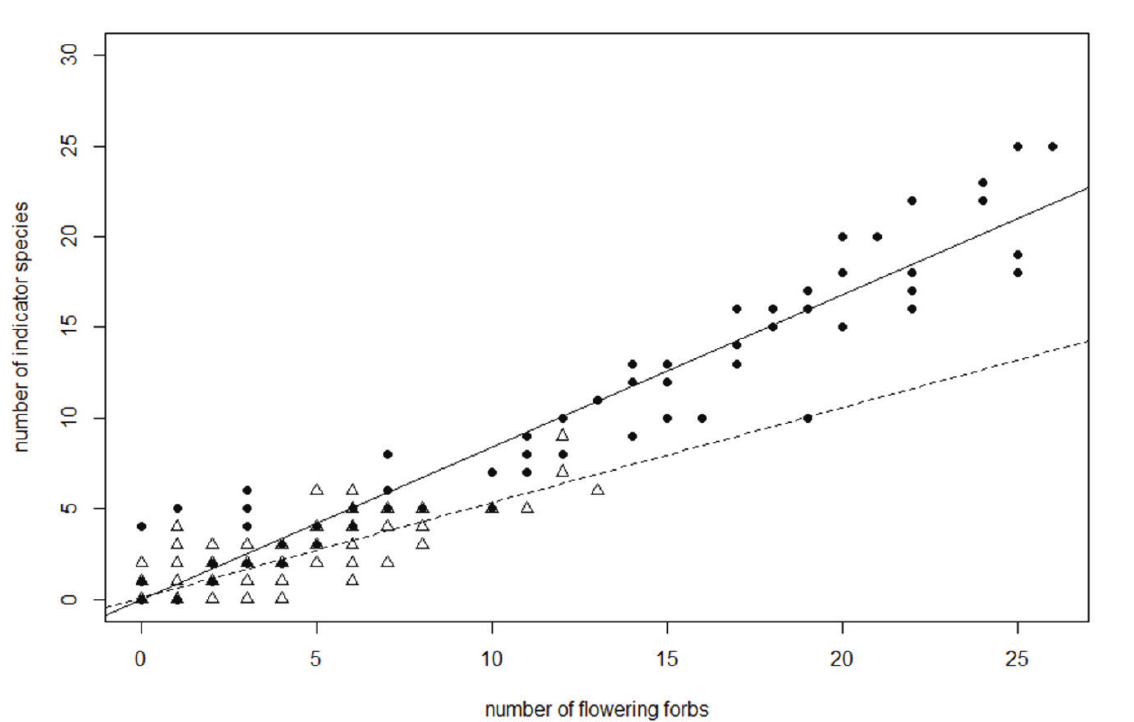
Figure 7. Relationship between the number of flowering forbs and the number of indicator species in arable land (triangles, dashed line) and grassland (filled circles, solid line) – data from 2016 (N = 615 arable and N = 67 grassland